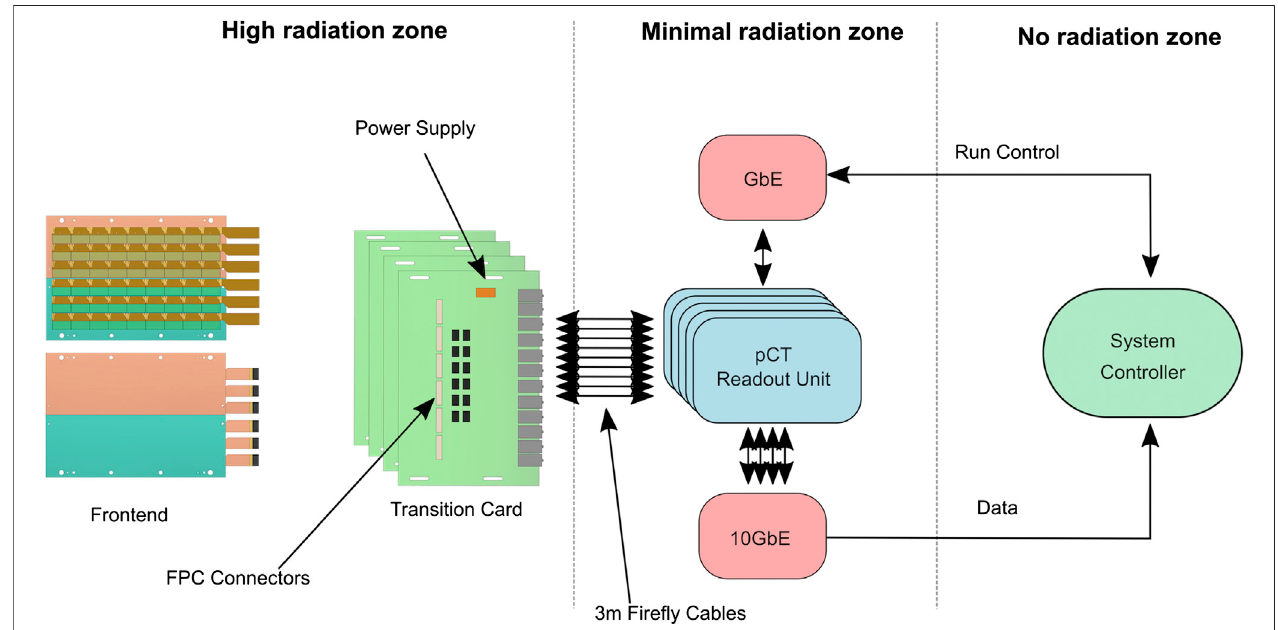
FIGURE 5 | The pCT system electronics